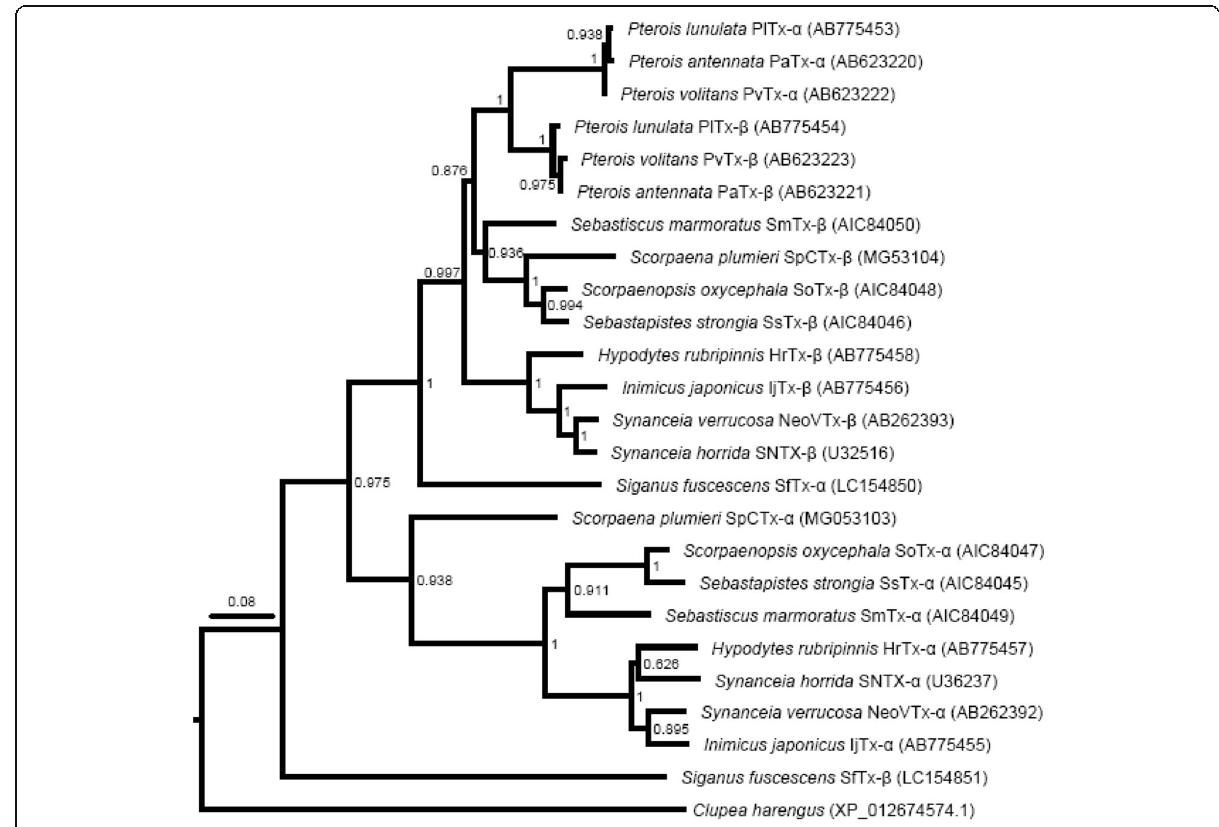
Fig. 6 Phylogenetic tree of Scorpaeniformes toxins. The tree was generated by the MUSCLE [42] and then analyzed with the Neighbor-Joining algorithm (bootstrap replicates: 500; substitution model: Maximum Composite Likelihood), both implemented in MEGA7 [43]. The selected sequences (DDBJ/EMBL/GenBank nucleotide databases) and the accession numbers are: AIC84049 and AIC84050 ( Sebastiscus marmoratus ), AIC84047 and AIC84048 ( Scorpaenopsis oxycephala ), AIC84045 and AIC84046 ( Sebastapistes strongia ), AB775453 and AB775454 ( Pterois lunulata ), AB623222 and AB623223 ( Pterois volitans ), AB623220 and AB623221 ( Pterois antennata ), AB775455 and AB775456 ( Inimicus japonicus ), AB775457 and AB775458 ( Hypodytes rubripinnis ), AB262392 and AB262393 ( Synanceia verrucosa ) and U36237 and U32516 ( Synanceia horrida ), LC154850 and LC154851 ( Siganus fuscescens ). As an outgroup, we included in the analysis a stonustoxin subunit beta-like protein sequence from Clupea harengus (accession number: